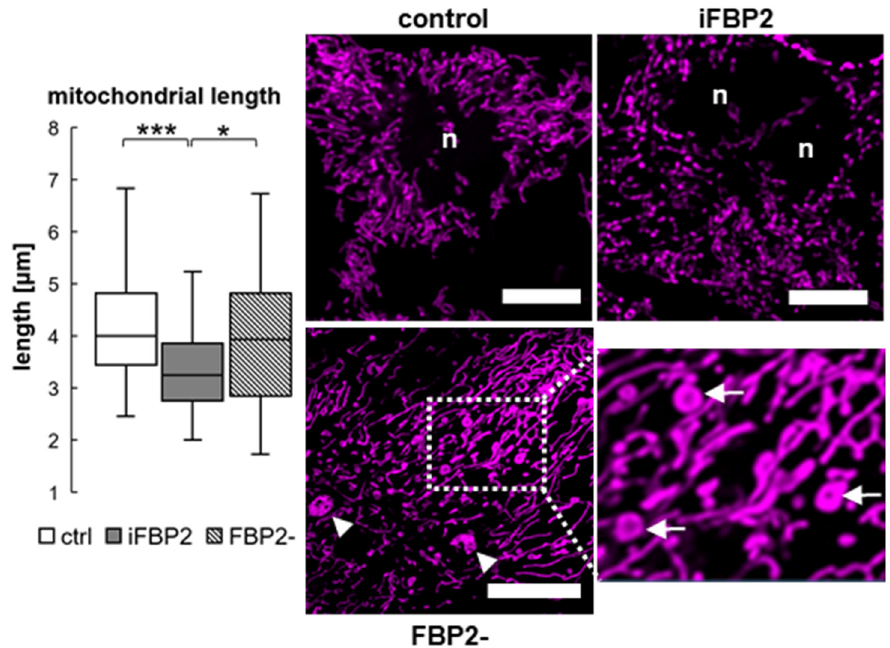
Figure 5. Mitochondrial length and morphology in HL-1 cells. Quantification of length of the organelles and representative microscopic images presenting the shape of mitochondrial network in different conditions. Ctrl—untreated HL-1 WT cells, iFBP2—FBP2 tetramerizing agent-treated cells; FBP2-—cells with partially silenced expression of FBP2; n—nucleus. Arrows point to donut-shaped mitochondria (in the magnified part of the FBP2- image), arrowheads point to aggregates observed in HL-1 FBP2- cells. Data are presented as median and interquartile range. * p < 0.05 *** p < 0.001. Bar = 10 µm.